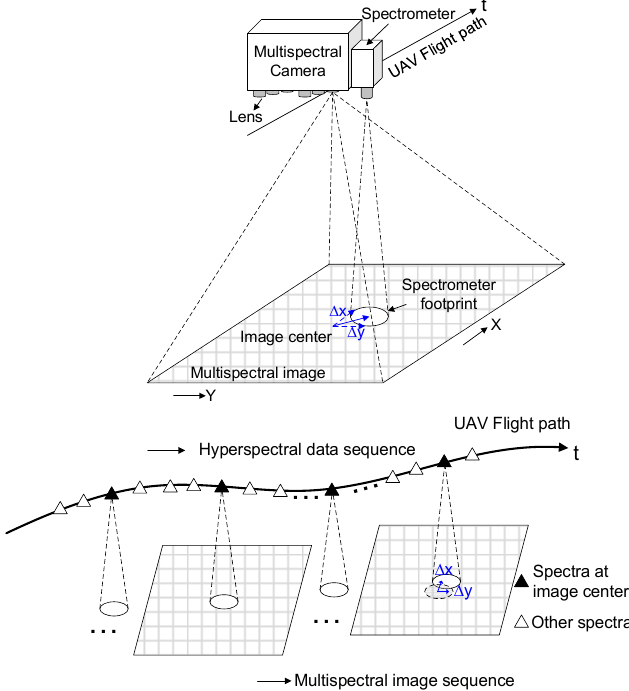
Figure 2. Need for alignment of the multispectral camera and spectrometer data. Δ x and Δ y are the offsets between the spectrometer data closest to the center of a multispectral image and the pixels at the center of the image. The offsets are caused by timing differences between the two sensors and by misalignment of the sensors’ optical axes. The goal was to determine and correct for Δ t , Δ x , and Δ y before performing fusion of the two data types.